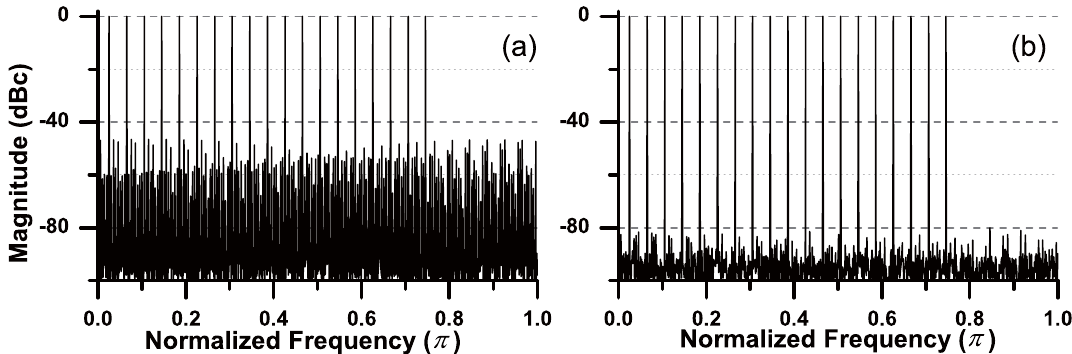
Figure 7. The spectra of 4-TIADC output ( a ) before and ( b ) after